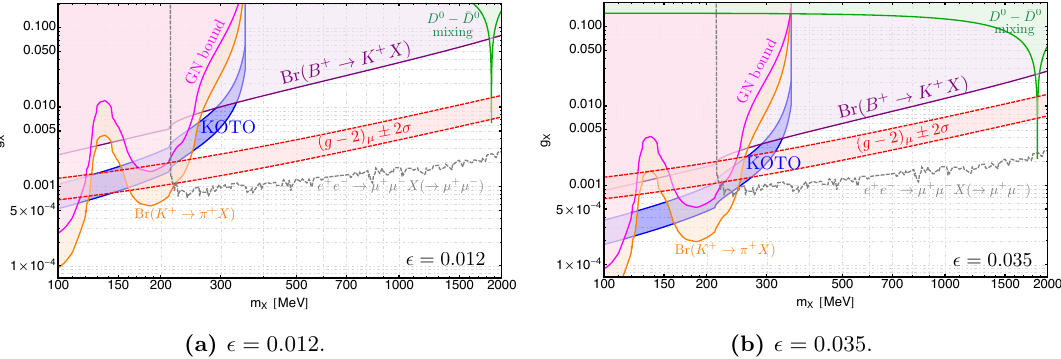
Figure 5. The preferred region for KOTO result and ( g 2) (cid:22) with a ( L (cid:22) L (cid:28) )+ (cid:15) ( B 3 L (cid:28) ) gauge (cid:0) (cid:0) (cid:0) boson X . All solid lines belong to B 3 coupling and dashed lines to L (cid:22) coupling. Blue shaded band is the region for KOTO desired Br( K 0 (cid:25) 0 X ) value. Red shaded band is the required value for L ! ( g 2) (cid:22) . The constraints from Br( B + K + X ) (purple), Br( K + (cid:25) + X ) (orange), GN bound (cid:0) ! ! (cid:22) D 0 mixing (green) and muonic force search in 4 (cid:22) channel (gray dashed) are also (magenta), D 0 (cid:0) shown. We show two di(cid:11)erent cases of the ratio (cid:15) between the muonic and the hadronic couplings as (cid:15) = 0 : 012 (Left panel) and (cid:15) = 0 : 035 (Right panel). See the main text for